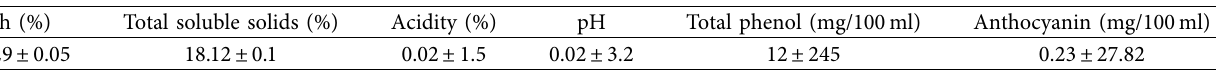
Table 4: Properties of pasteurized pomegranate juice ∗